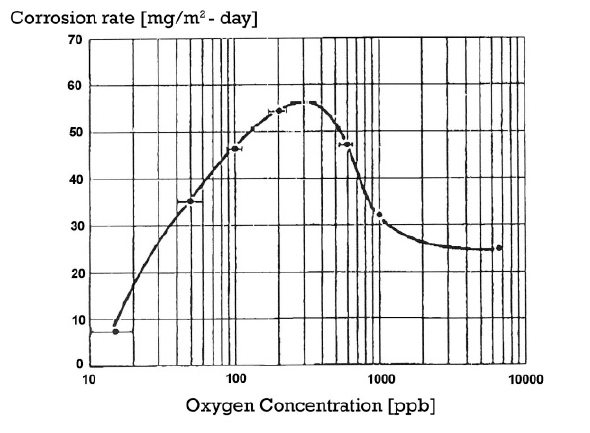
Figure 1: Corrosion rate vs.